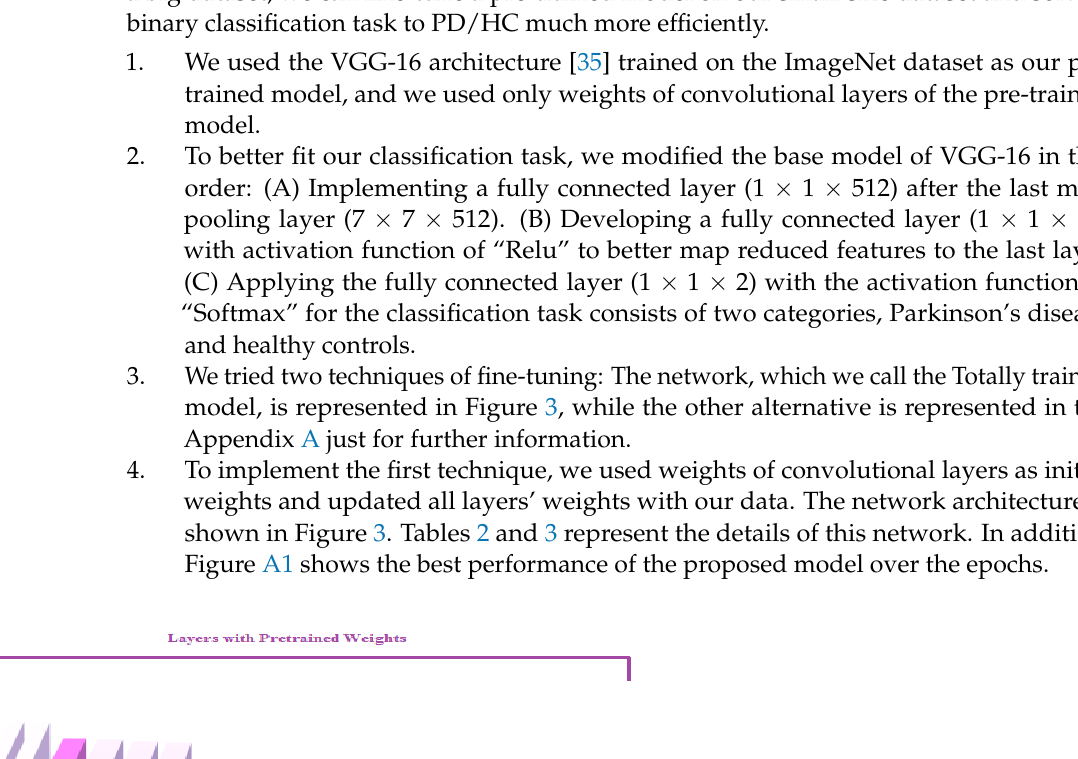
Figure 2. ( A ) Subject 11 DC of healthy class in the alpha band. ( B ) Subject 10 (Total Unified Par- kinson’s Disease Rating Scale (UPDRS) = 22) DC of Parkinson class in the alpha band.